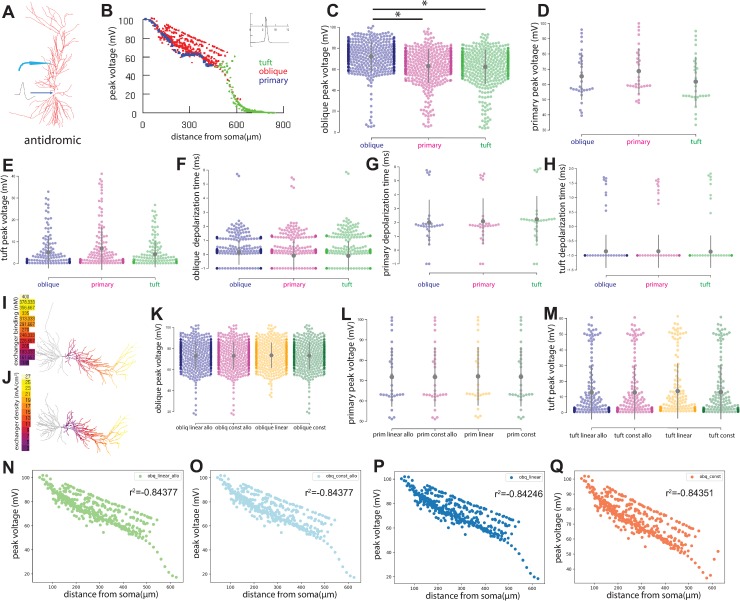
Simulation models on the effect of sodium calcium exchange current on back propagating action potentials.(A) Antidromic propagation was measured in all apical compartments after somatic stimulation. (B) Visual representation of the experimental set-up whereby absolute peak voltage for each apical compartment is represented by a colored dot and coded to map onto the primary, oblique, and tuft dendrite. Inset graphs the action potential triggered at the soma. (C-E) Absolute peak voltage from apical compartments was recorded during back propagating actin potentials while the Na+/Ca2+ exchange current was introduced to the oblique (C), primary (D), or tuft regions (E). (F-H) The depolarization time from each apical compartment was examined during back propagation when the Na+/Ca2+ exchange current was localized to the oblique (F), primary (G), or tuft dendrites (H). (I-J) Visual depictions of the linear models of NCX allostery (I) and NCX density (J). (K-M) Absolute peak voltage from oblique (K), primary (L), and tuft (M) apical regions were recorded while modeling linear and constant models of NCX allostery (linear allo and const allo), and linear and constant models of NCX density (linear and const). (N-Q) Correlation plots of absolute peak voltage from the oblique dendrite and distance from soma for the linear allostery model (N), constant allostery model (O), linear density model (P), and constant density model (Q). * indicates p < 0.005. Statistics calculated using the Mann Whitney U (α = 0.05) and Tukey HSD (FWER = 0.05) tests.